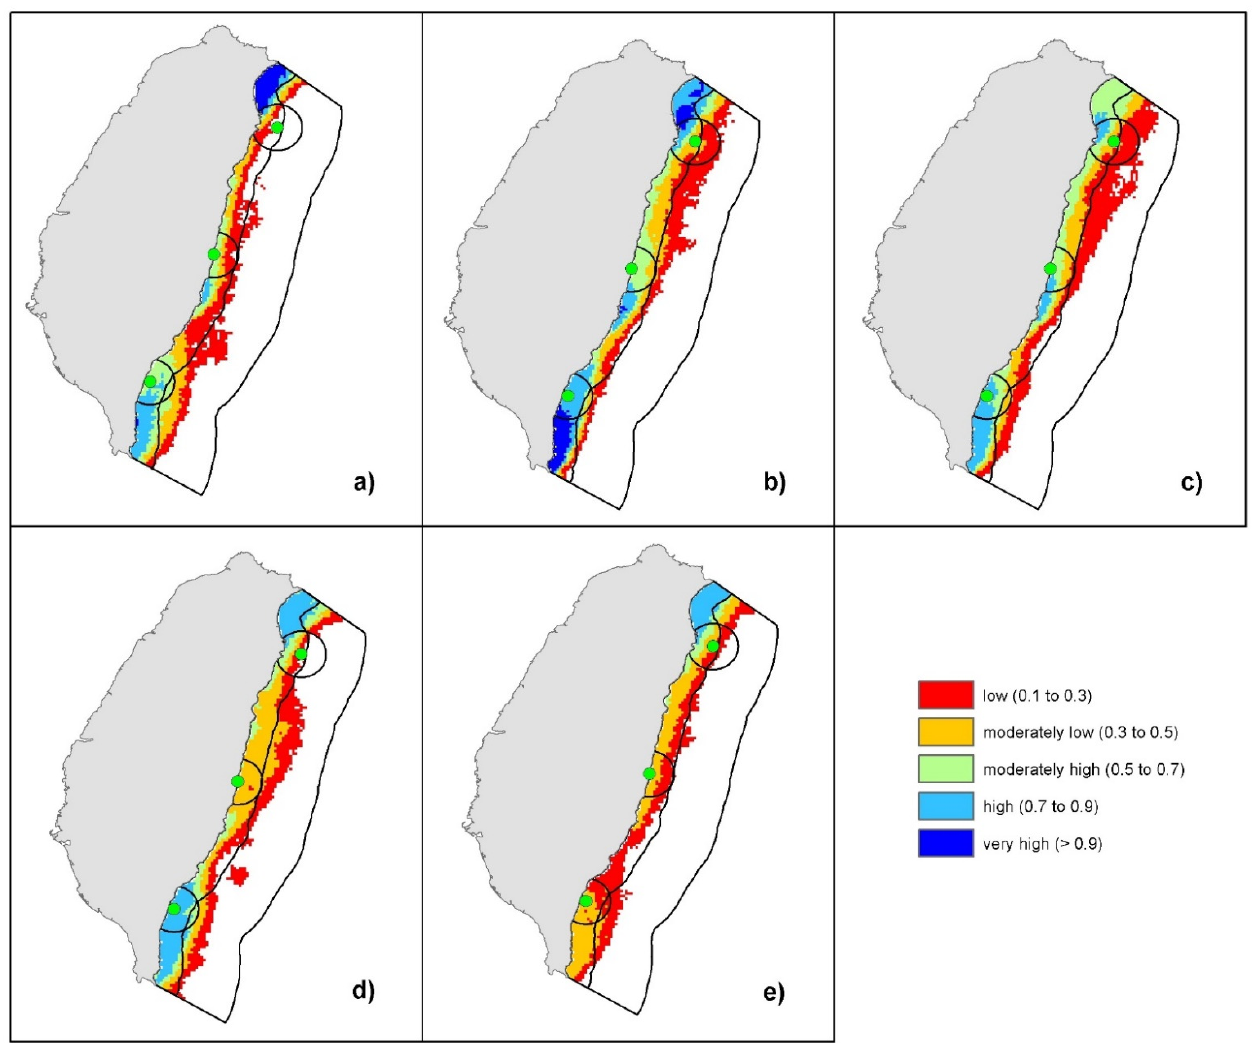
Figure 8. The monthly upwelling frequency map were generated by combining the daily upwelling maps of the corre- sponding months; ( a ) May, ( b ) June, ( c ) July, ( d ) August, ( e ) September. The frequency is divided into five categories: low, moderately low, moderately high, high, and very high.